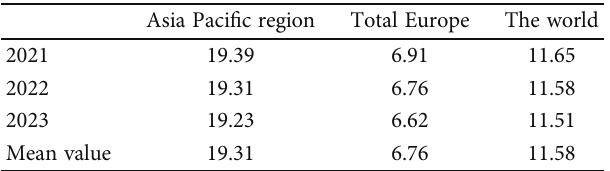
Table 19: The annual increase rates of renewable energy consumption